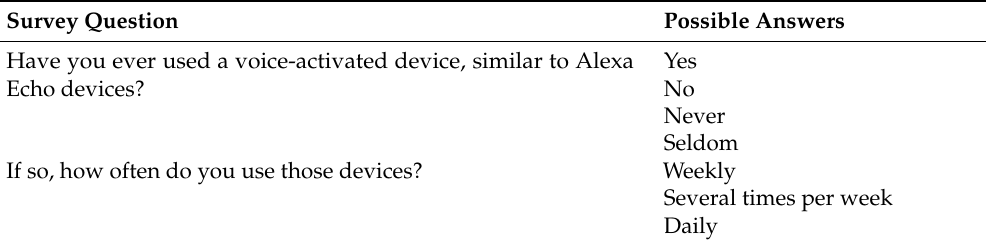
Table 3. Initial survey to students (Extract taken from Saiz-Manzanares et al. [23]). Survey Question Possible